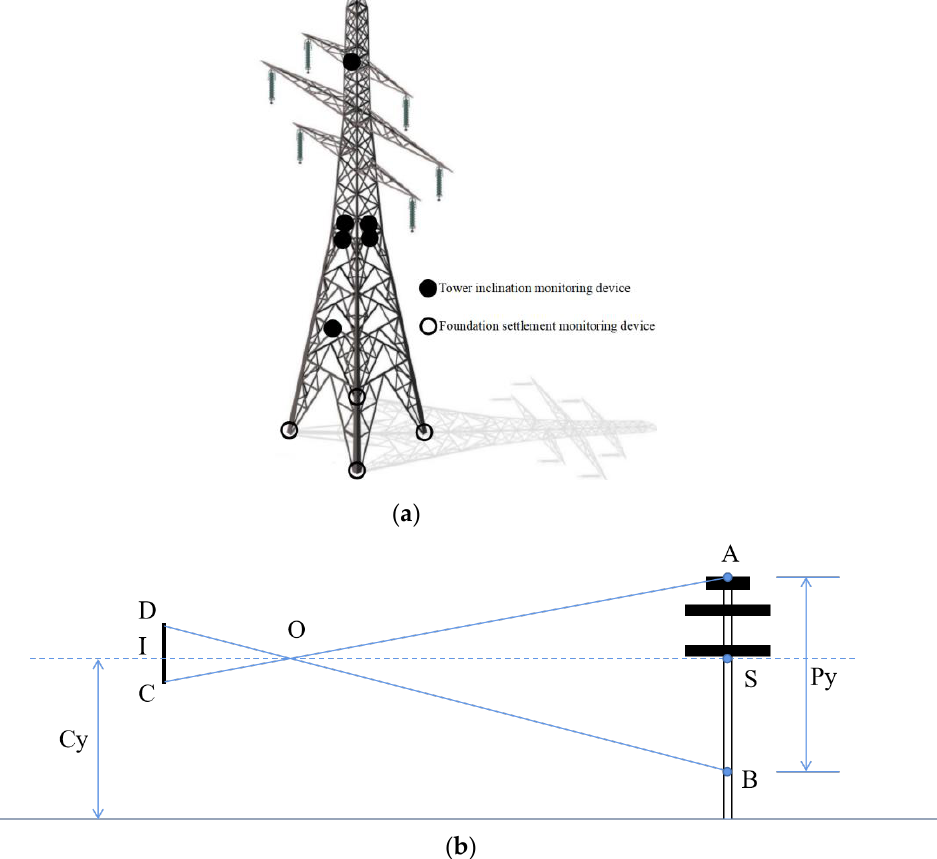
Figure 7. Schematic representation of the monocular visual imaging images: ( a ) Schematic of transmission line tower tilt monitoring auxiliary system; ( b ) Schematic diagram of the rod and tower imaging.